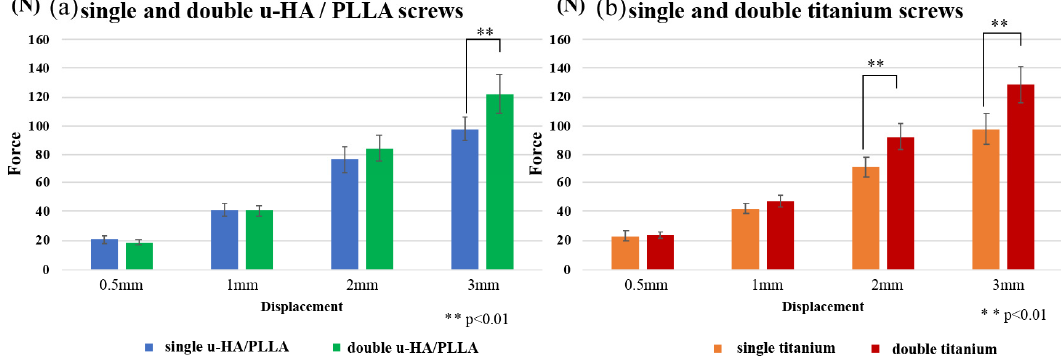
Figure 5. Horizontal loading tests. These graphs show the comparison of single and double u-HA / PLLA screws ( a ) and comparison of single and double titanium screws ( b ).